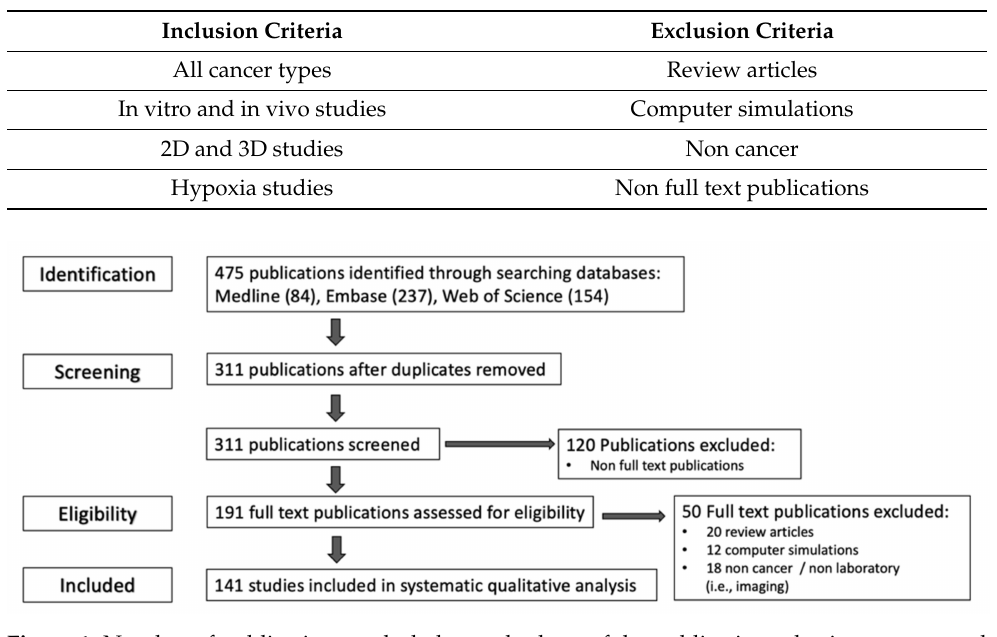
Figure 1. Number of publications excluded at each phase of the publication selection process and reasons for